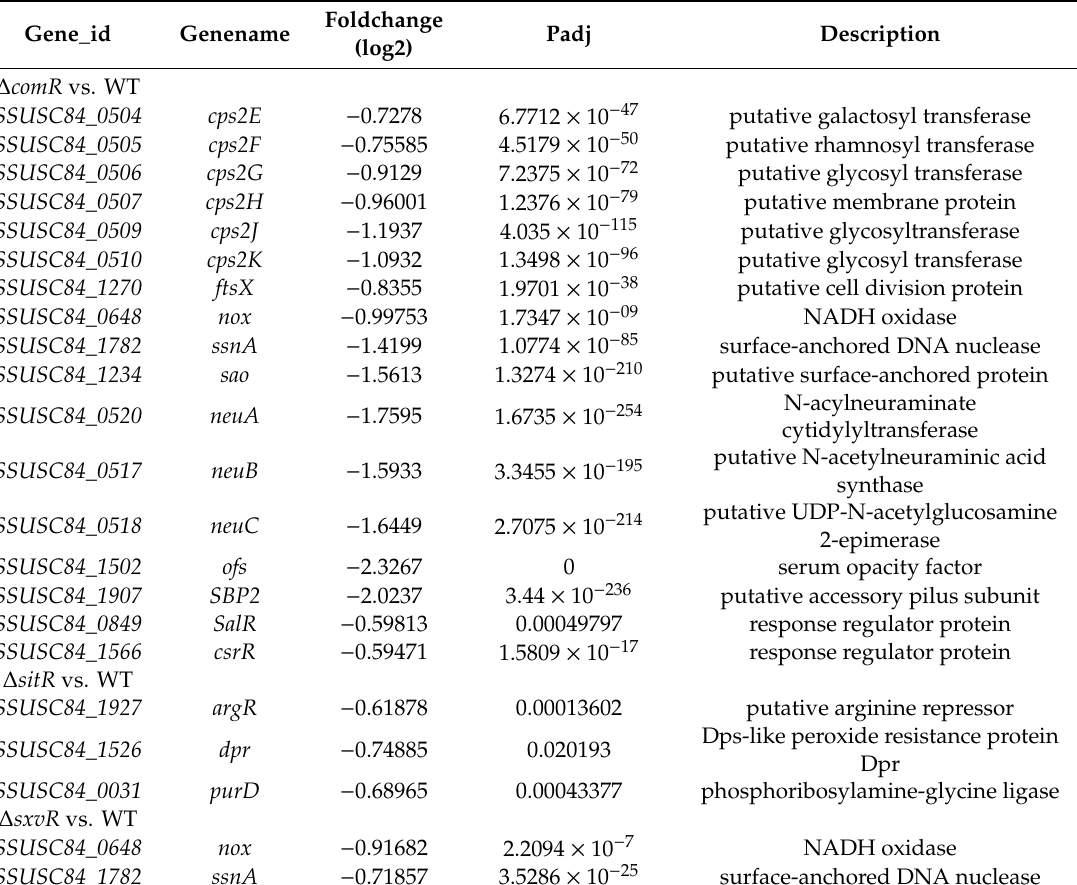
Table2. Virulence-associatedfactor(VFG)genesin S.suis ∆ comR , ∆ sitR ,and ∆ sxvR mutants, asidentified by